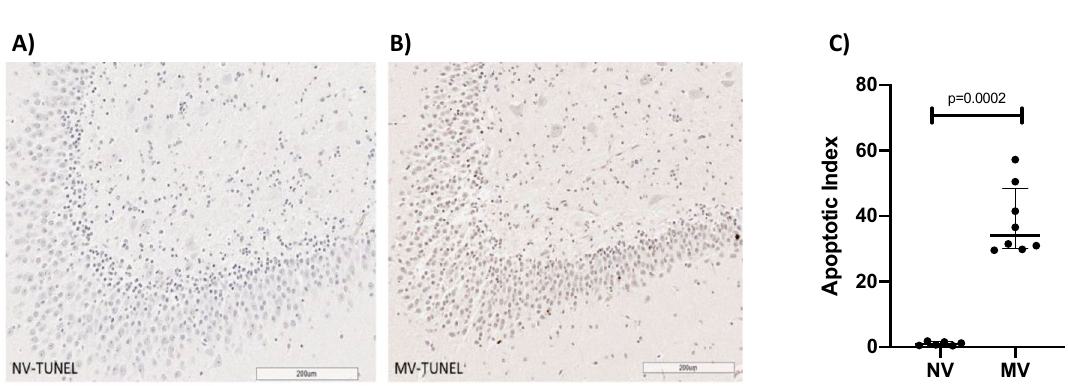
Figure 1. Slides of an NV subject’s hippocampus ( A ) and an MV subject’s hippocampus ( B ) after staining by doublecortin (DCX) assay, showing normal cells (blue) and doublecortin-positive cells (brown). Greater neurogenesis can be observed in the MV example than in the NV example. ( C ) Dot plot showing mitotic indices of 19.07 (17.84–21.38) in the NV group and 26.04 (24.41–30.34) in the MV group, p = 0.0022 (n = 6 per group).